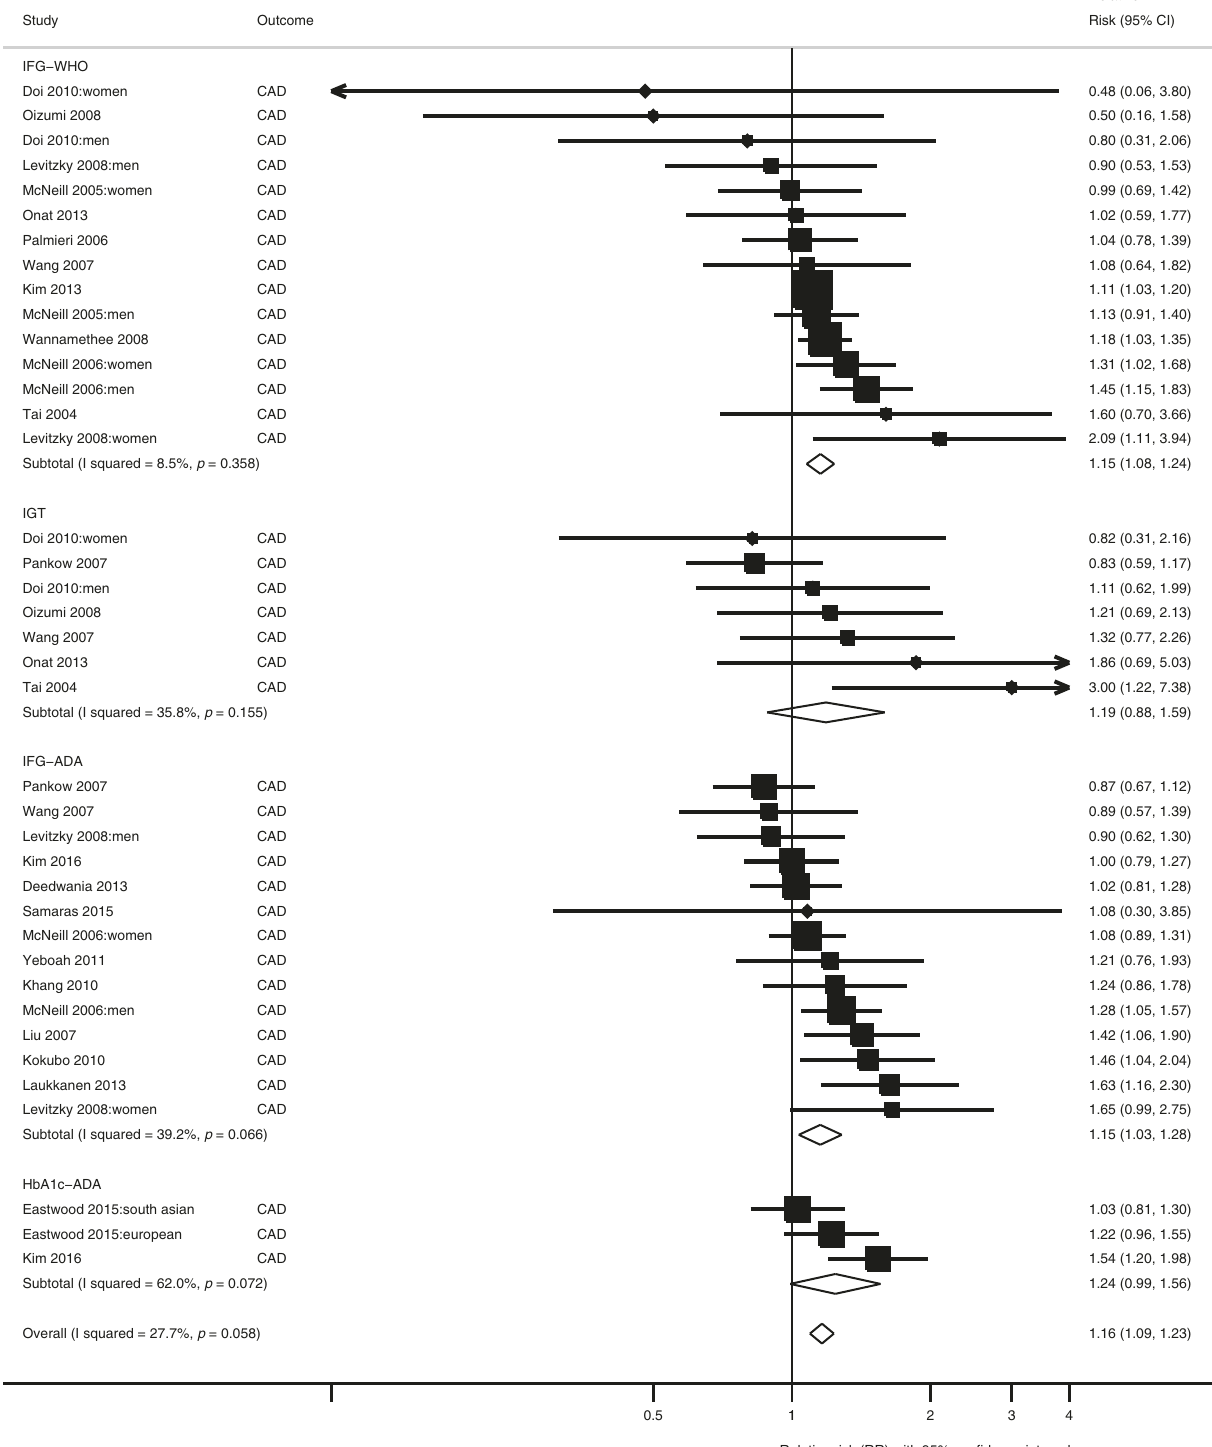
Overall (I squared = 27.7%, p =